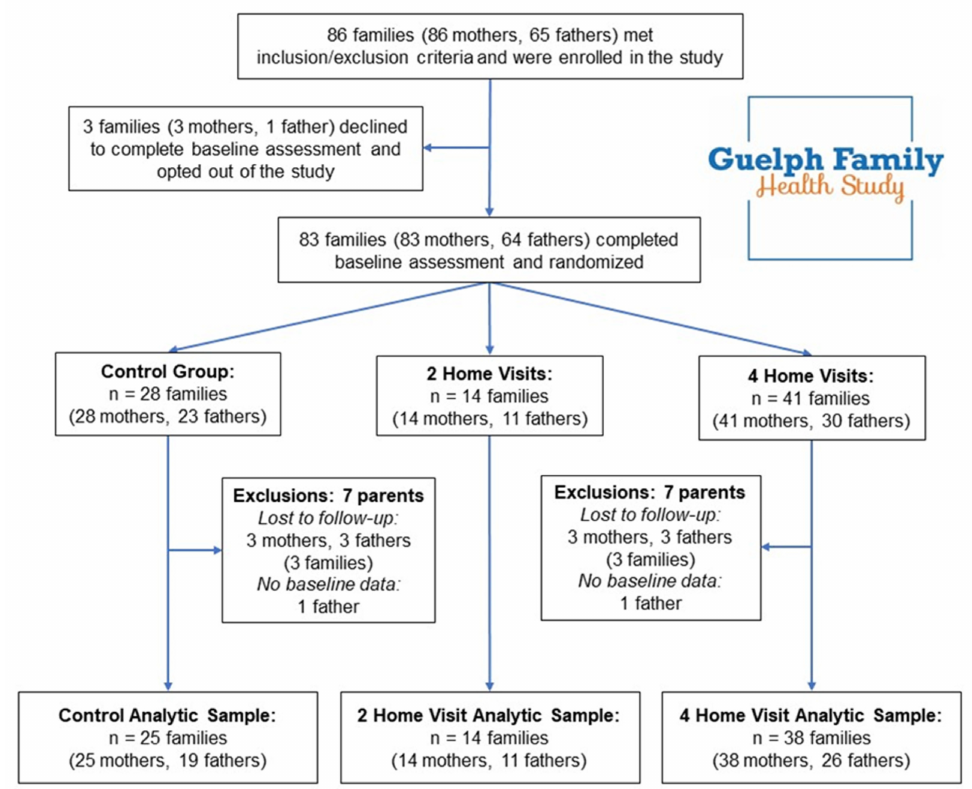
Figure 1. Study design and participant flow of the analytic sample from the Guelph Family Health Study Pilot Phase 1 and Phase 2 parent